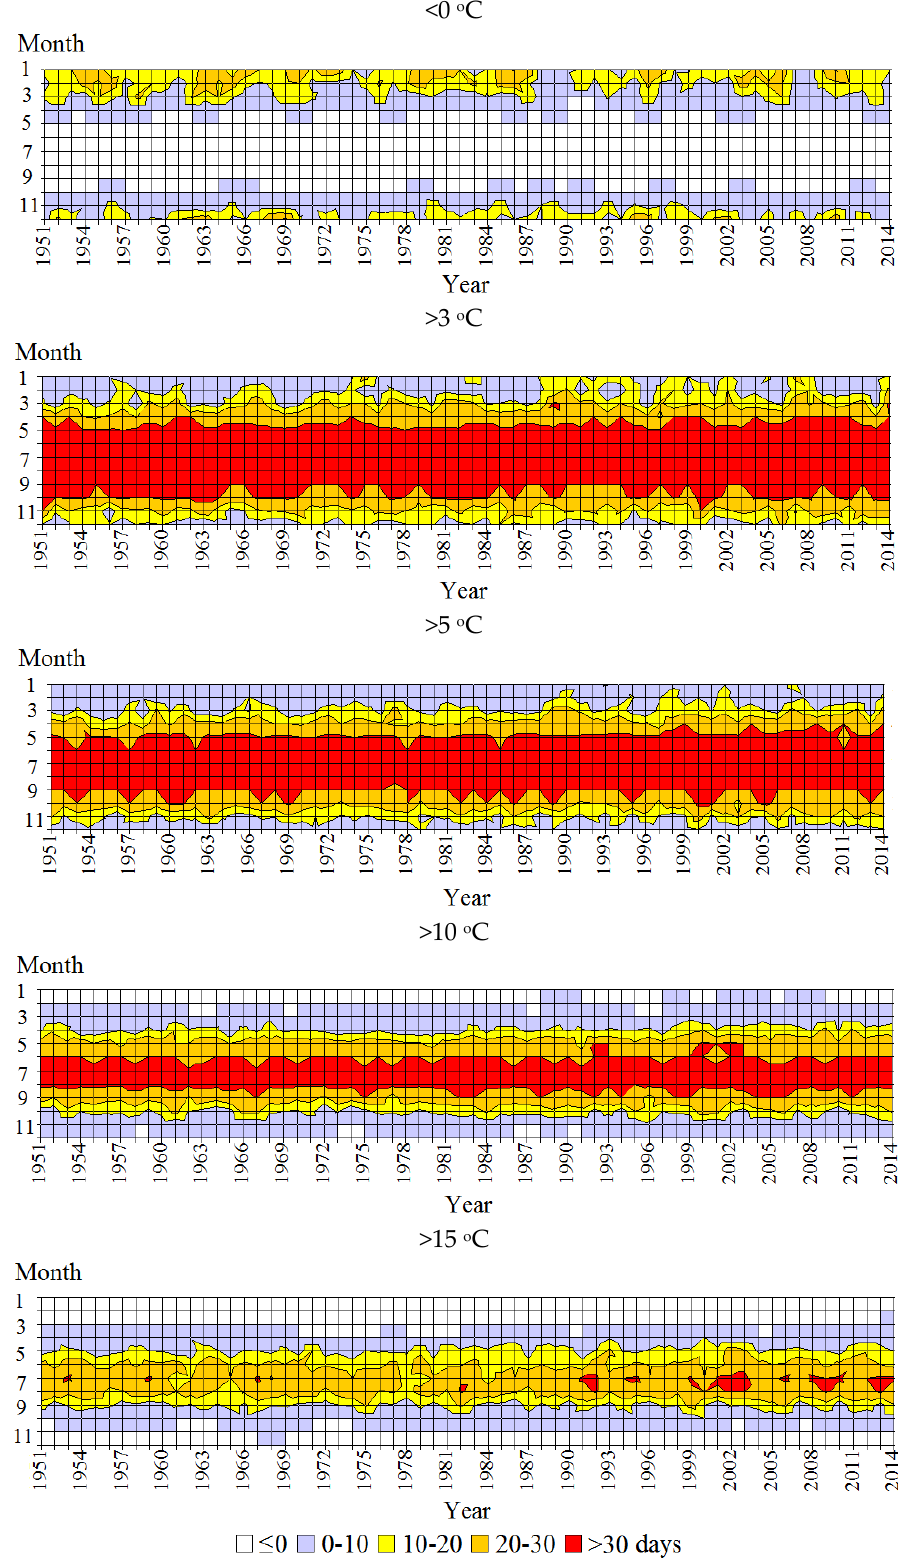
Figure 6. Time distribution of the number of days with air temperature (Ta) characterizing thermal agricultural periods: winter dormancy of plants (<0 °C), farming (>3 °C), vegetation (>5 °C), active plant growth (>10 °C), and maturation of plants (>15 °C) in the studied region, 1951–2014. These results are slightly different from those obtained for the area of south-western Poland.